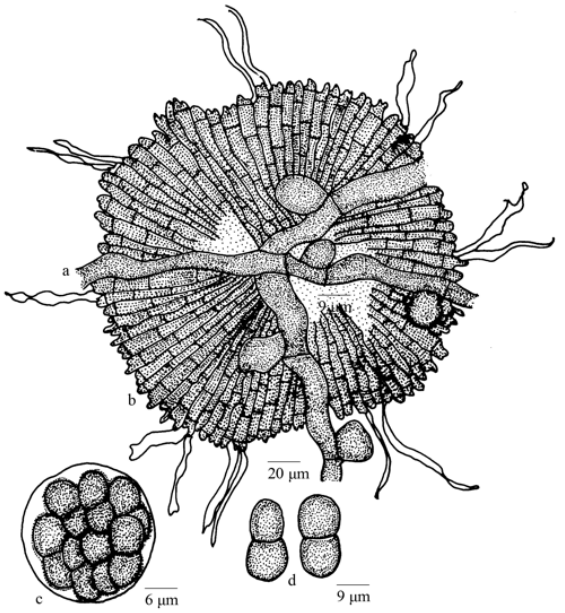
Figure 164. Asterina sabiacearum a - Appressoriate mycelium; b - Thyriothecium; c - Ascus; d -